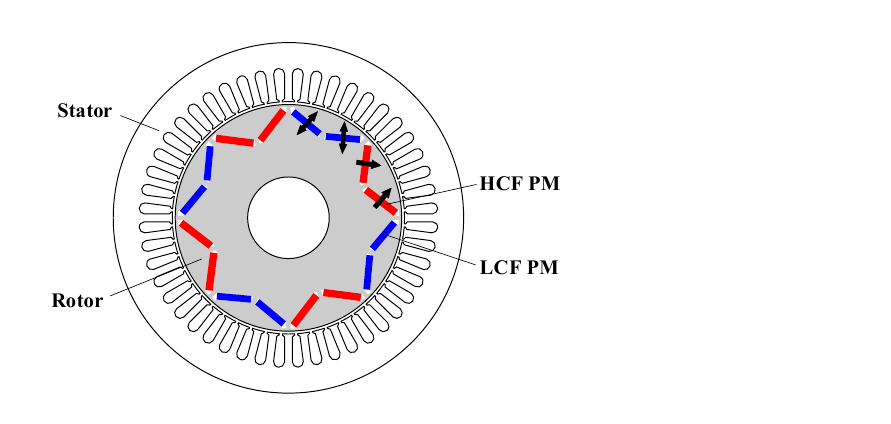
Figure 30. 48 ‐ slot/8 ‐ pole series hybrid PM VFM machine with distributed armature windings [80].